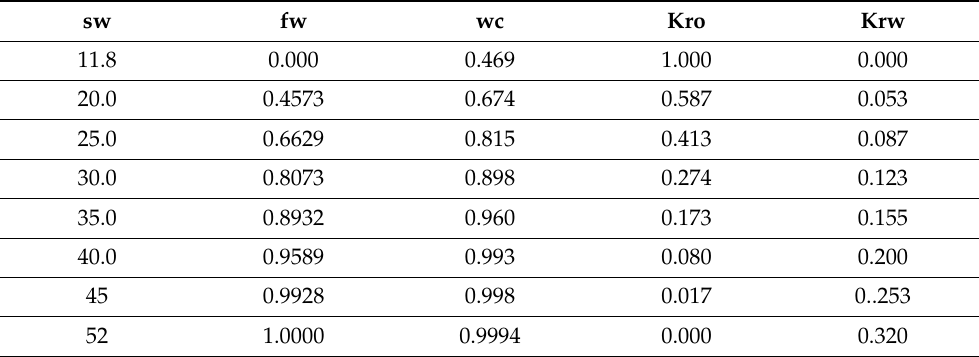
Table 10. Resulting relative permeabilities, fractional flow and water cut values of oil. Sw versus fw for Hummar formation, µ o = 2.8 cp, µ w = 0.3 cp.